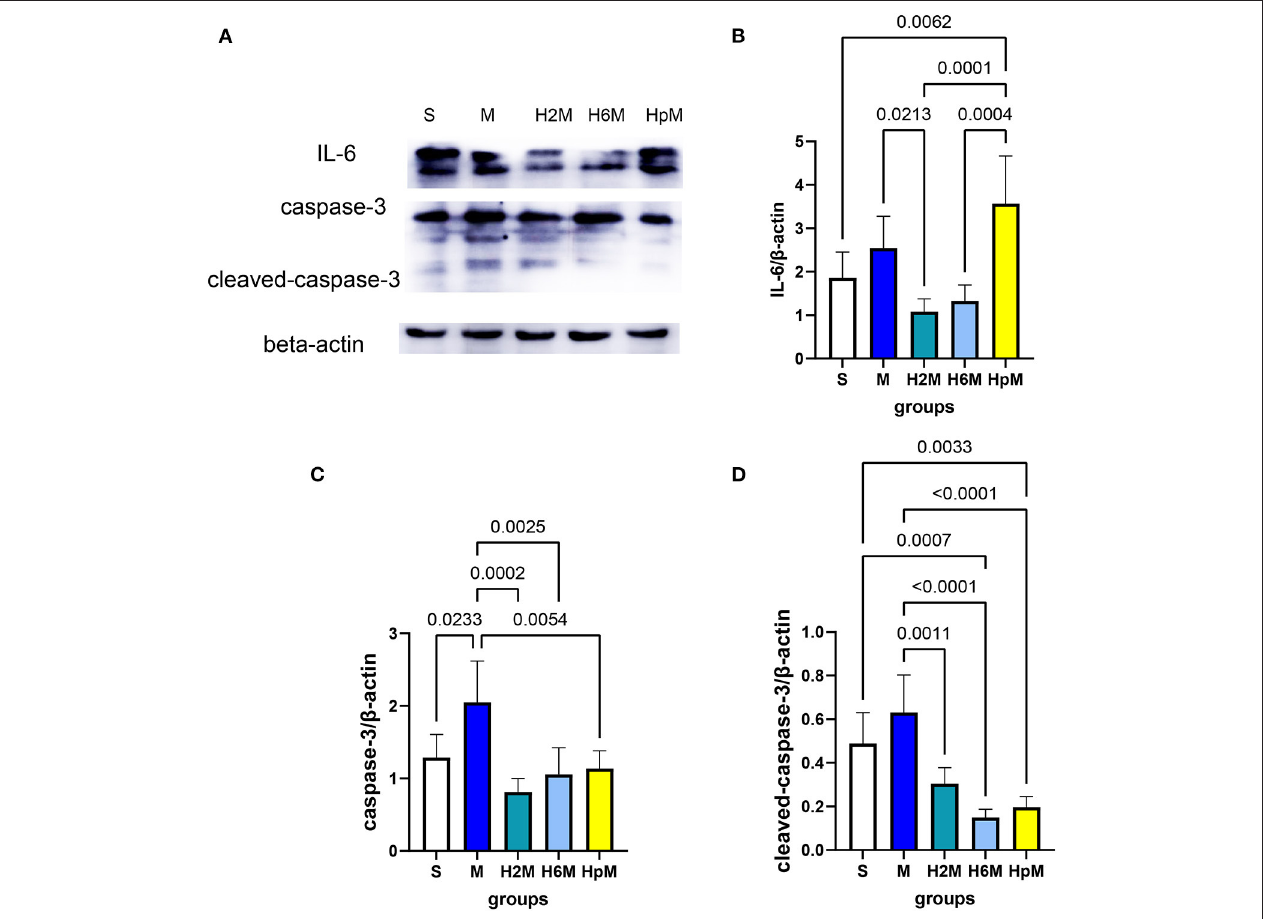
FIGURE 4 | Relative expression of IL-6, caspase-3, and cleaved-caspase-3. (A) Immunoblot results of IL-6, caspase-3, and cleaved-caspase-3. (B) Analysis of IL-6 relative expression. One-way ANOVA showed differences among the five groups, F = 10.86, p < 0.0001. (C) Analysis of caspase-3 relative expression. One-way ANOVA showed differences among the five groups, F = 8.50, p = 0.0004. (D) Analysis of cleaved-caspase-3 relative expression. One-way ANOVA showed differences among the five groups, F = 17.36, p < 0.0001. ANOVA, analysis of variance; caspase-3, cysteinyl aspartate specific proteinase 3; IL-6, interleukin 6.